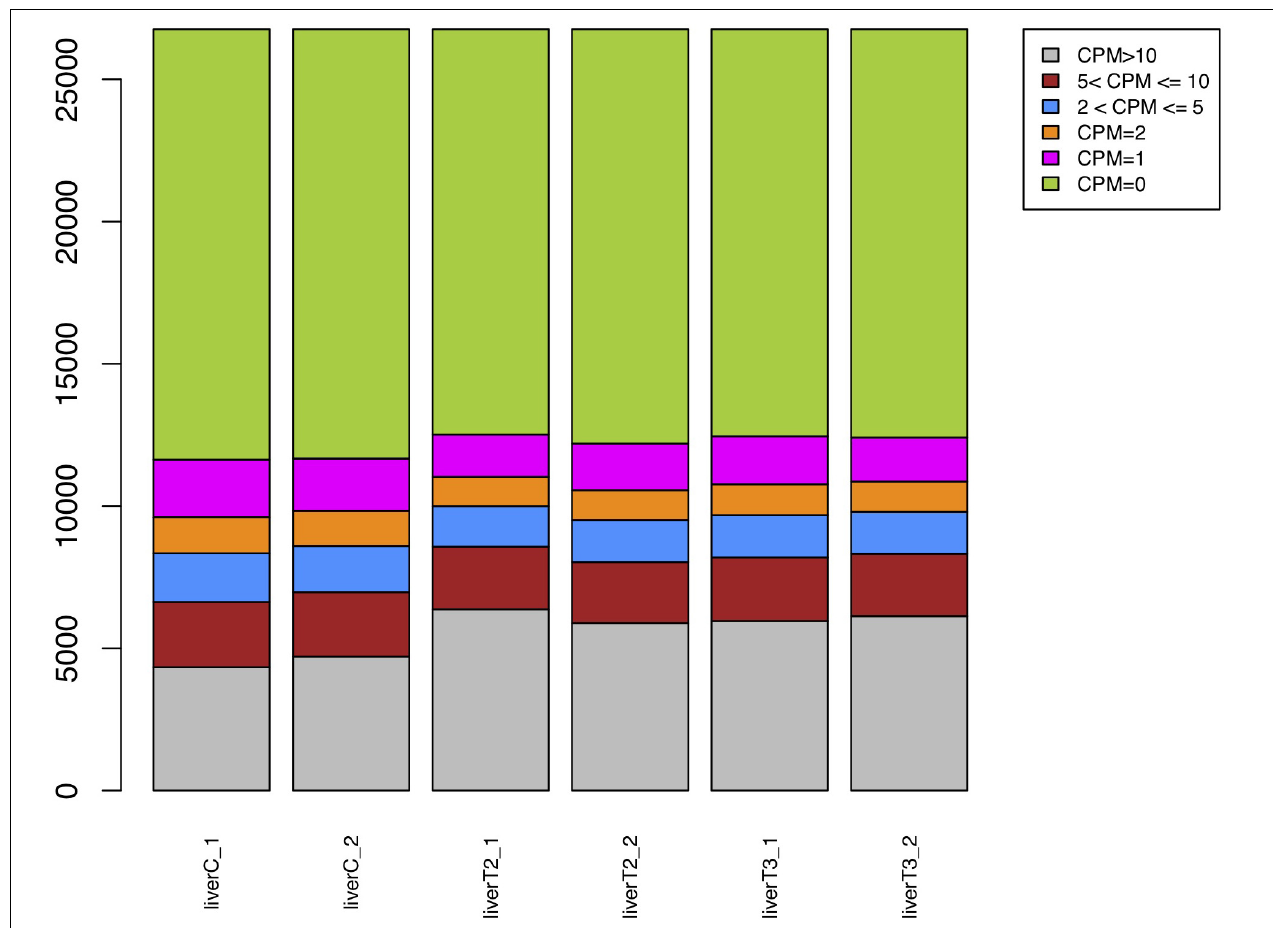
FIGURE 2 | CPM plot. A bar plot for each sample is generated where Counts Per Million for each gene are